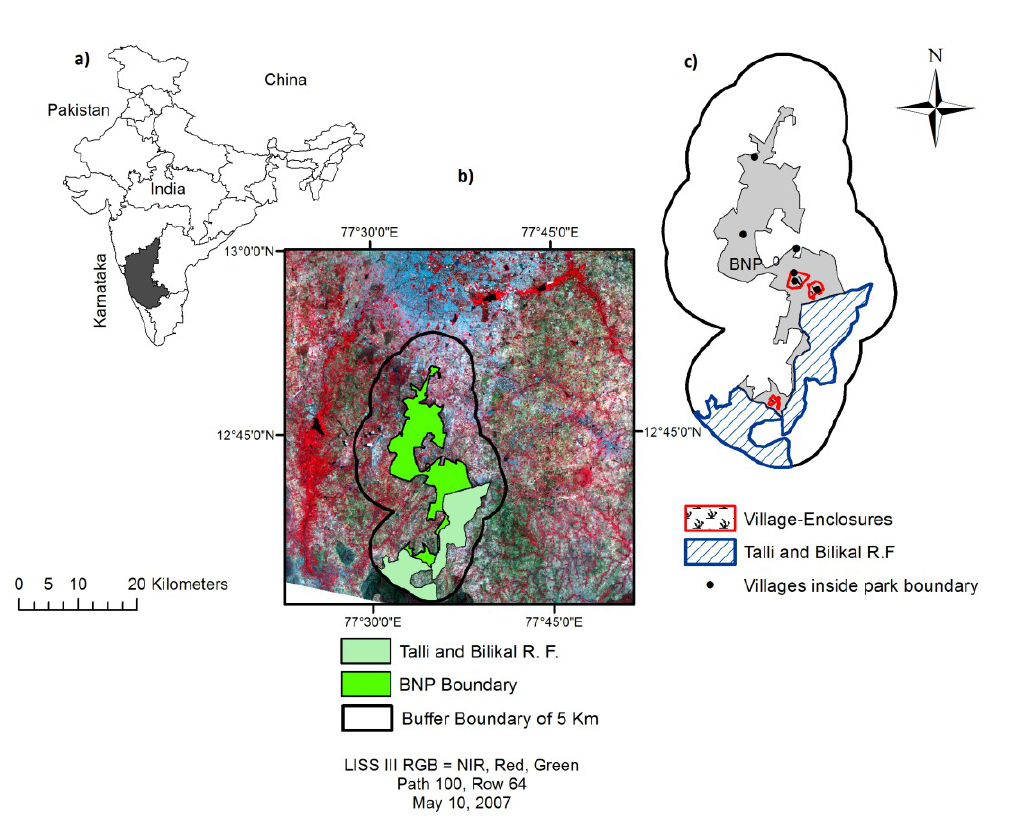
Figure 1. Map showing the study area of BNP and 5 km buffer around the park boundary.